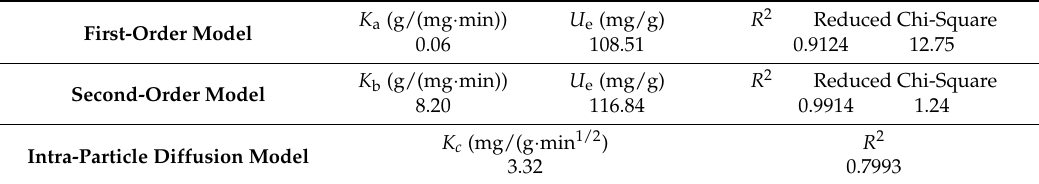
Table 1. Kinetic parameters for Ag(I) adsorption by BA-PGMA.